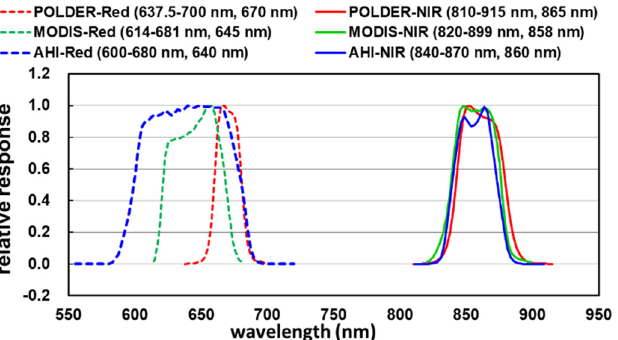
Figure 1. Relative spectral responses for POLDER, MODIS, and AHI in the red and NIR bands. POLDER-Red, MODIS-Red and AHI-Red refer to the results for POLDER, MODIS and AHI data in the red band, respectively; POLDER-NIR, MODIS-NIR and AHI-NIR are the results for the three sensors in the NIR band.